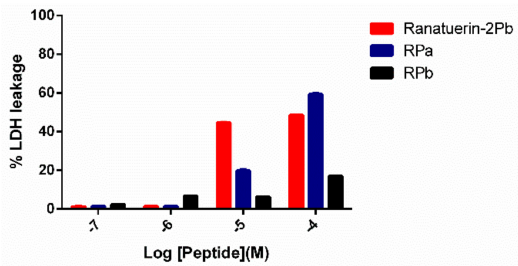
Figure 7. LDH leakage in H157 cells after 30 min of treatment with peptides at di ff erent concentrations in serum-free medium. Ranatuerin-2Pb, RPa and RPb are labelled as red, blue and black, respectively.